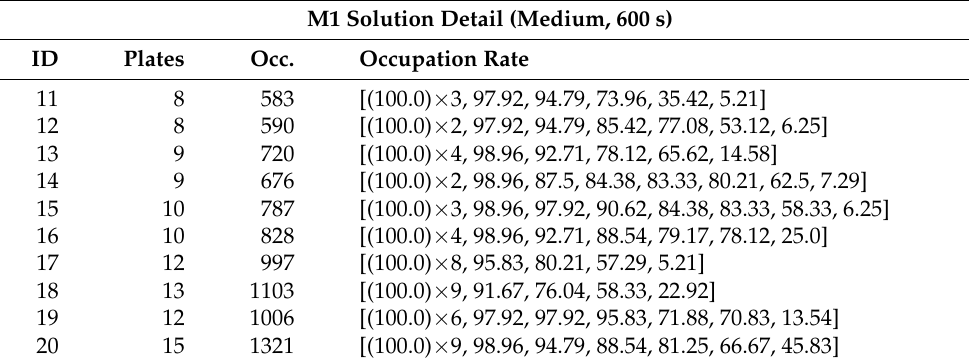
Table A12. M1 solutions detailed for medium files, limited to